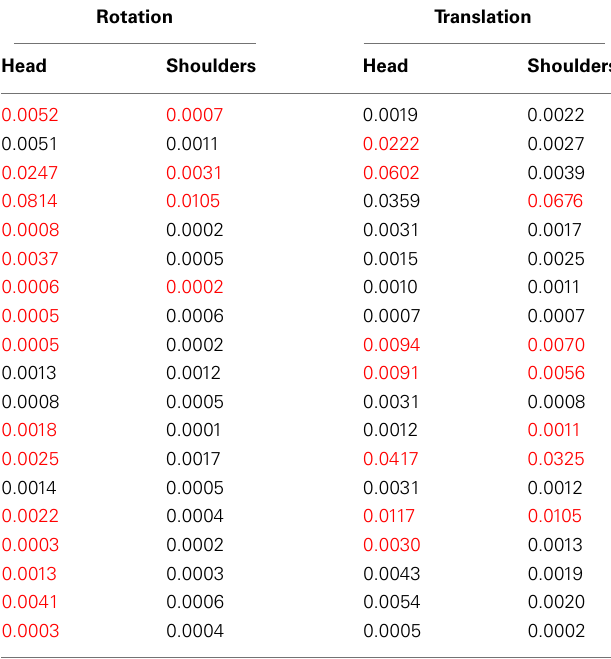
Table 1 | Spontaneous rotation coefficients for rotation and translation, for the head and